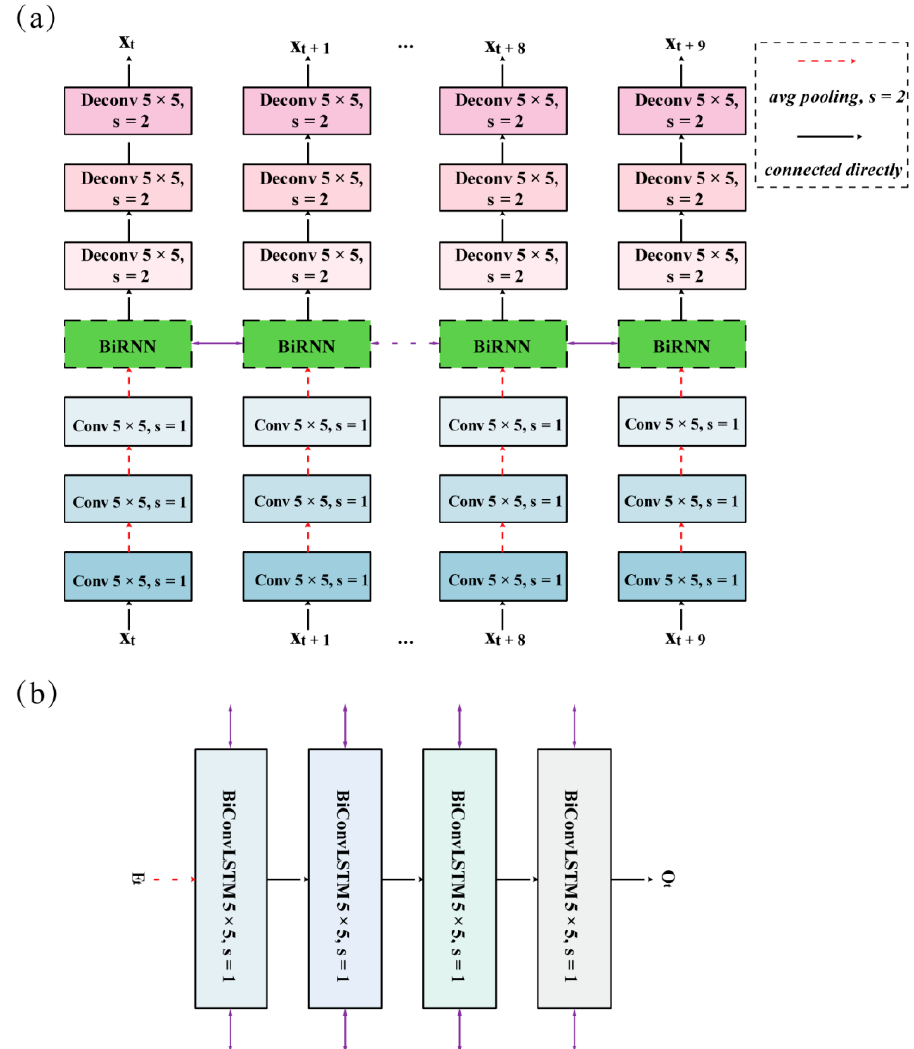
Figure 1. ( a ) Network architecture of the convolutional neural networks (CNNs) combined with bi-directional convolutional long short-term memory networks (CNN-BiConvLSTM) model. ( b ) Network architecture of bi-directional recurrent neural network (BiRNN) in ( a ). X denotes input radar images, E denotes features encoded by the CNN encoder, O denotes features encoded by the BiRNN encoder, and s denotes strides of the